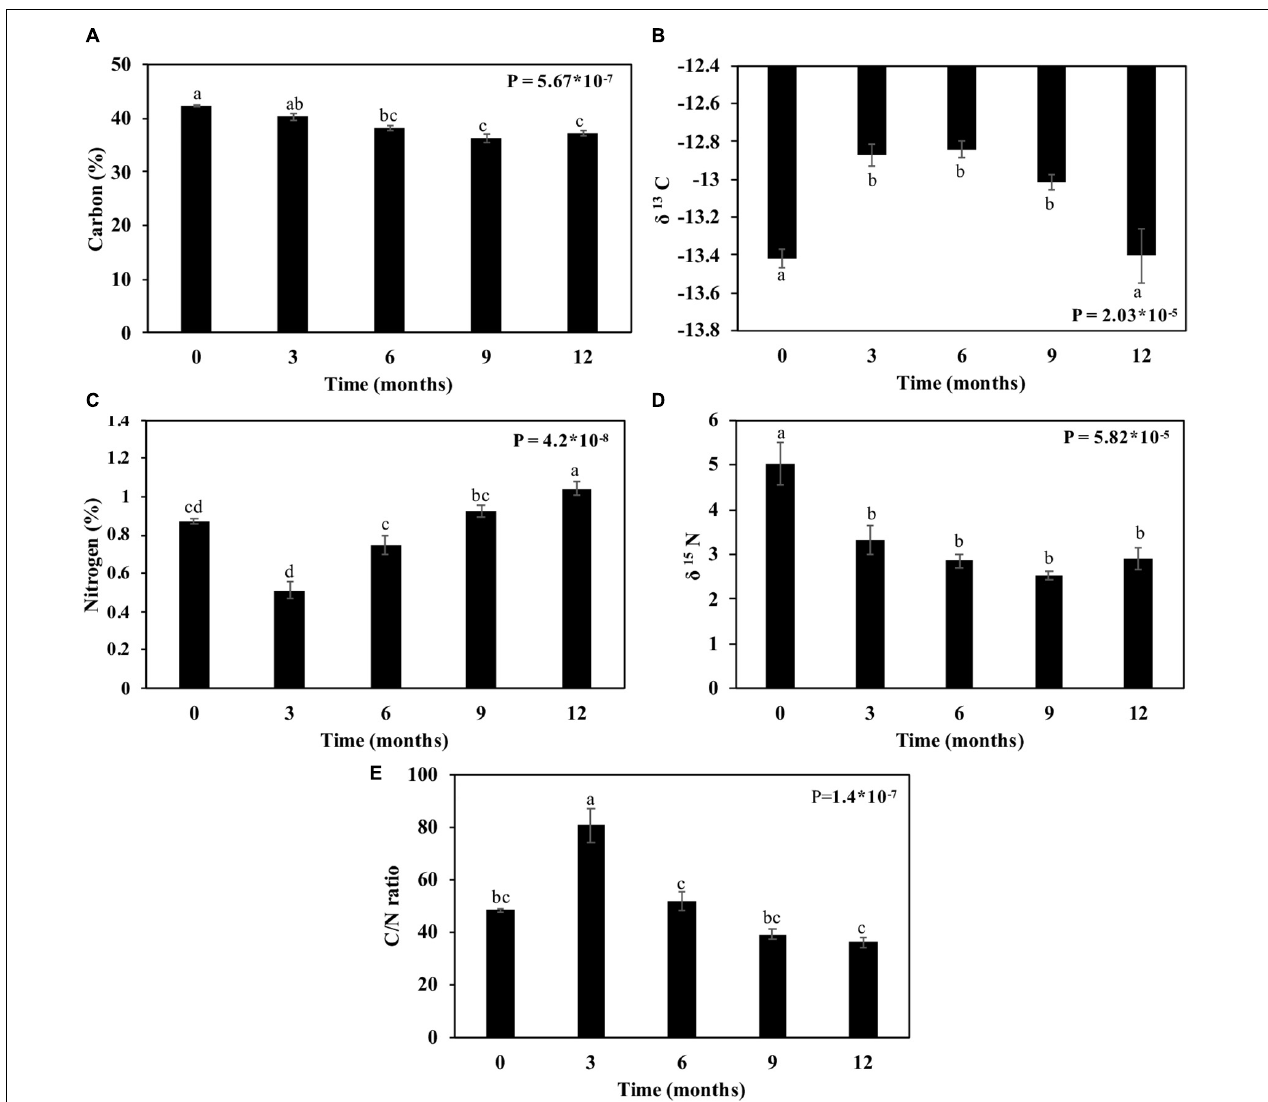
FIGURE 9 | Carbon and nitrogen contents in sugarcane straw under field conditions for 12 months. (A) Percentage of carbon. (B) δ 13 C ratio. (C) Percentage of nitrogen. (D) δ 15 N ratio. (E) C/N ratio. Bars represent average ± standard error. Different letters are significant differences by Tukey’s test ( P < 0.05; n =